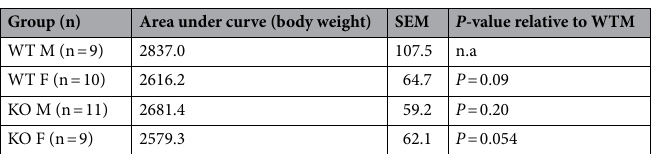
Table 1. Body weight area under the curve analysis of surviving